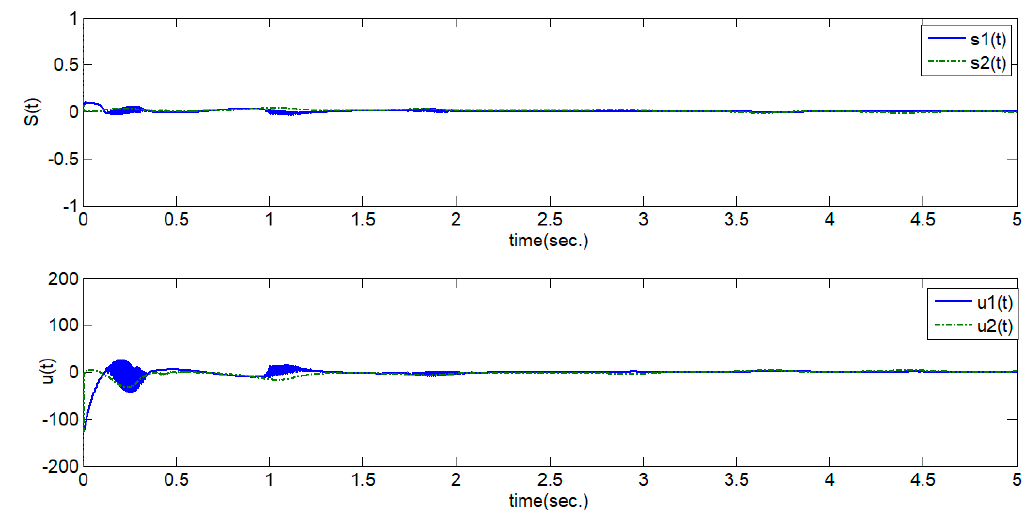
Figure 7. The time responses of the proposed SMC controller and the sliding surface.